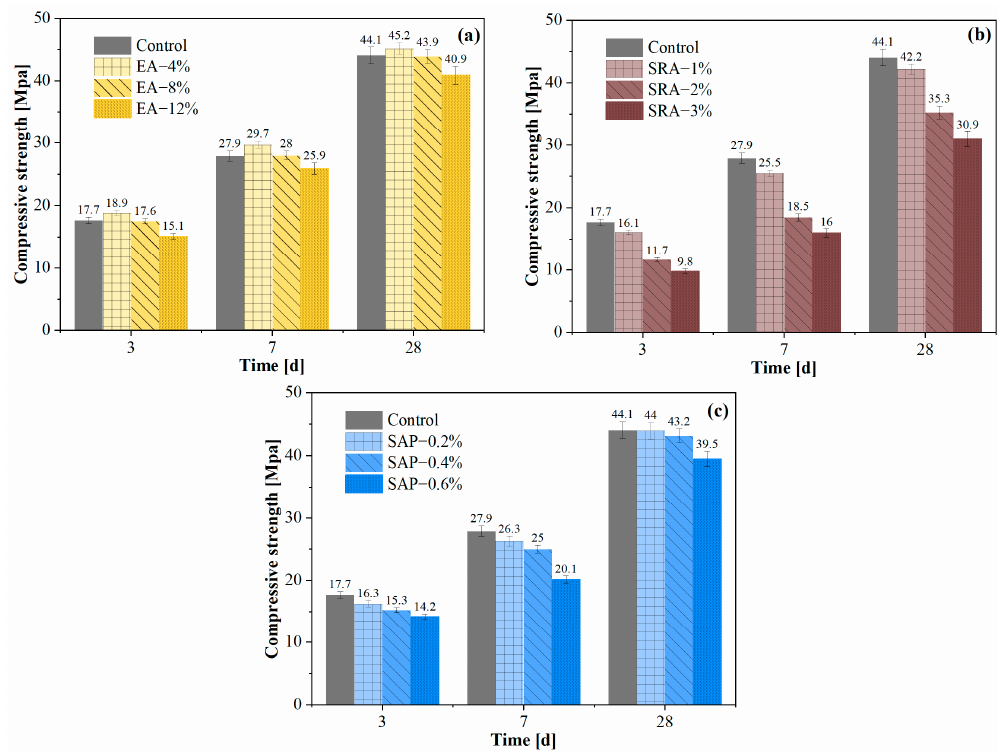
Figure 8. Compressive strength of secondary lining concrete at 3 d, 7 d and 28 d: ( a ) EA ( b ) SRA ( c ) SAP.